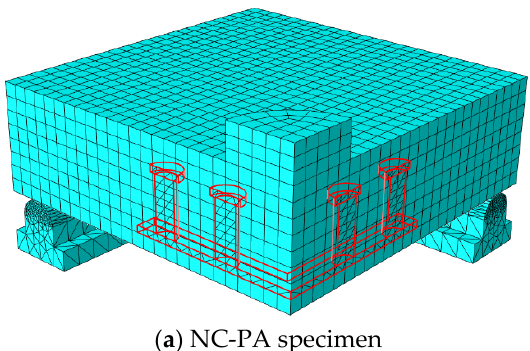
Figure 13. Numerical model of NC slab.